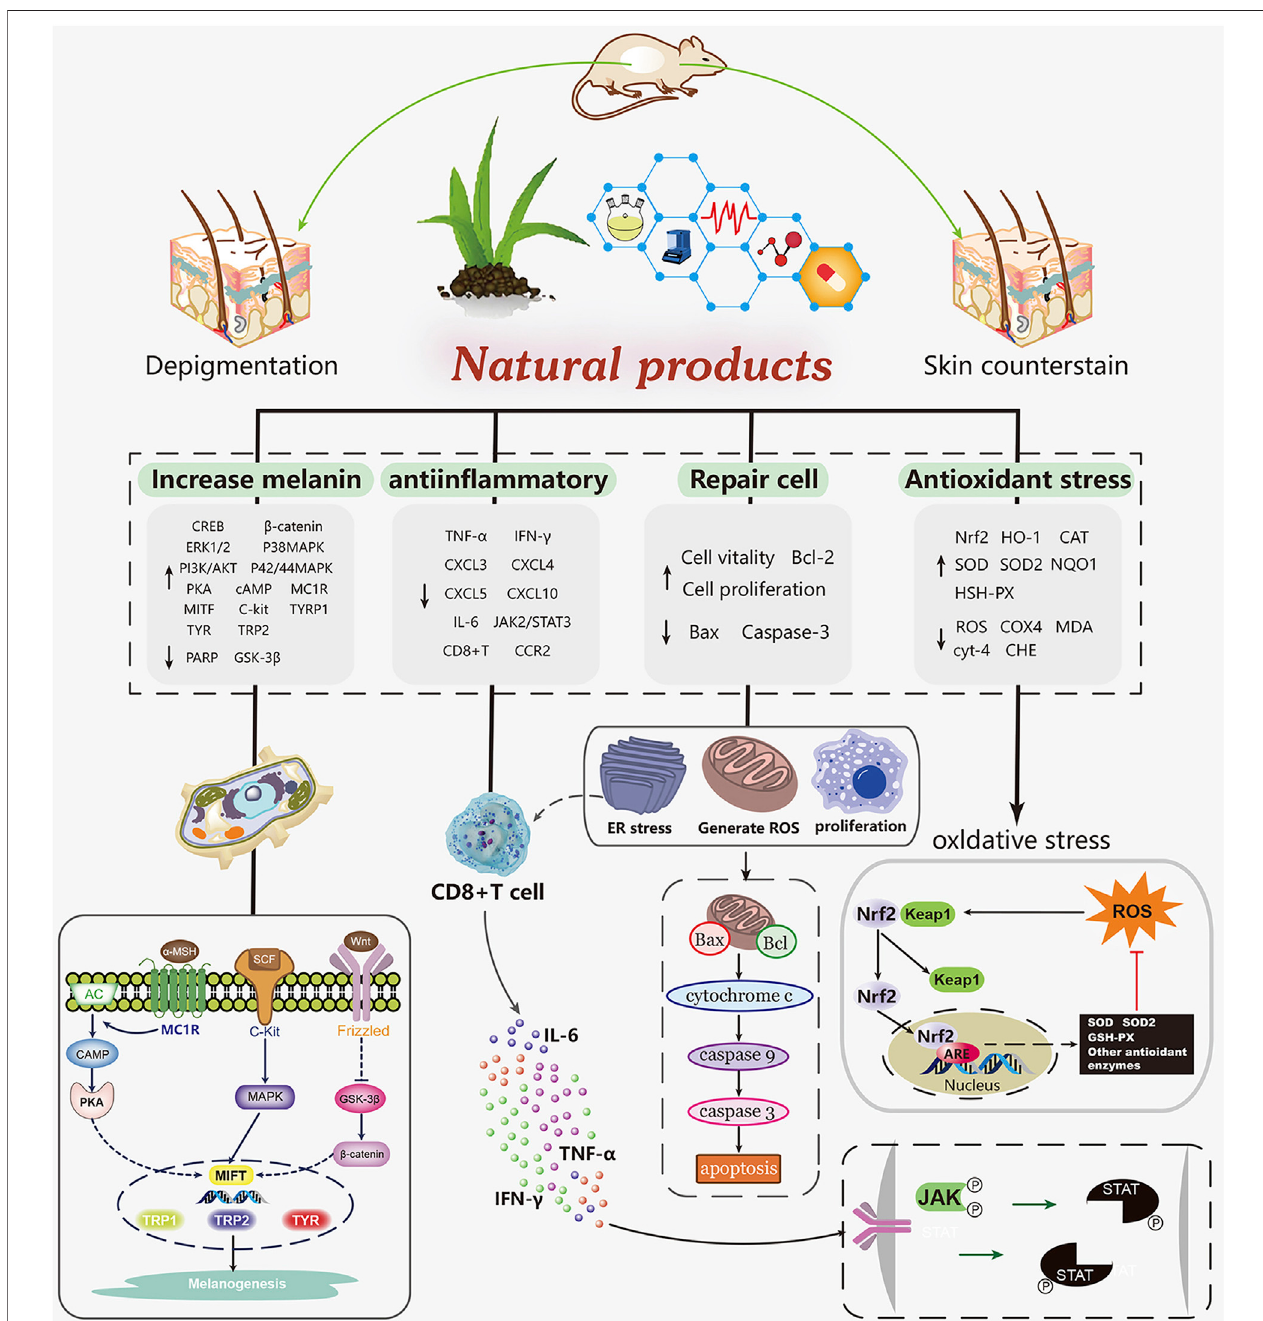
FIGURE 2 | Mechanism of natural products in the treatment of vitiligo.